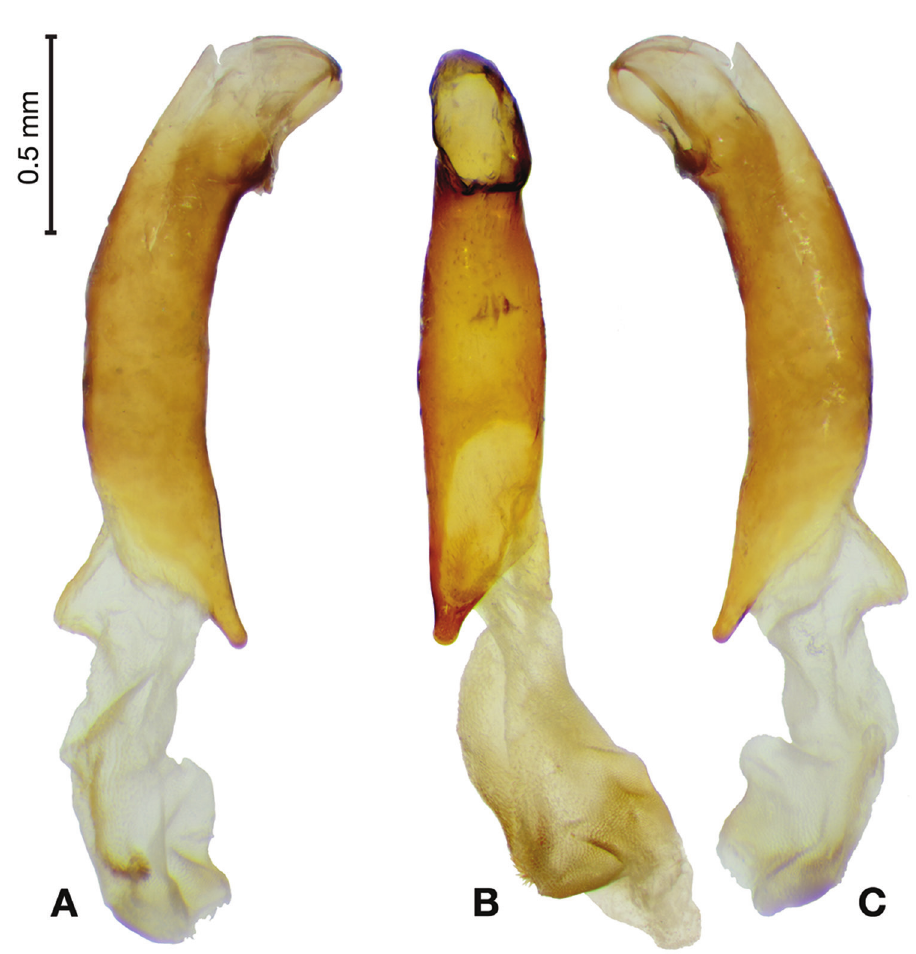
Figure 92. Digital images of the male genitalia, endophallus everted, of Miscelus javanus Klug. A right lateral aspect B ventral aspect C left lateral